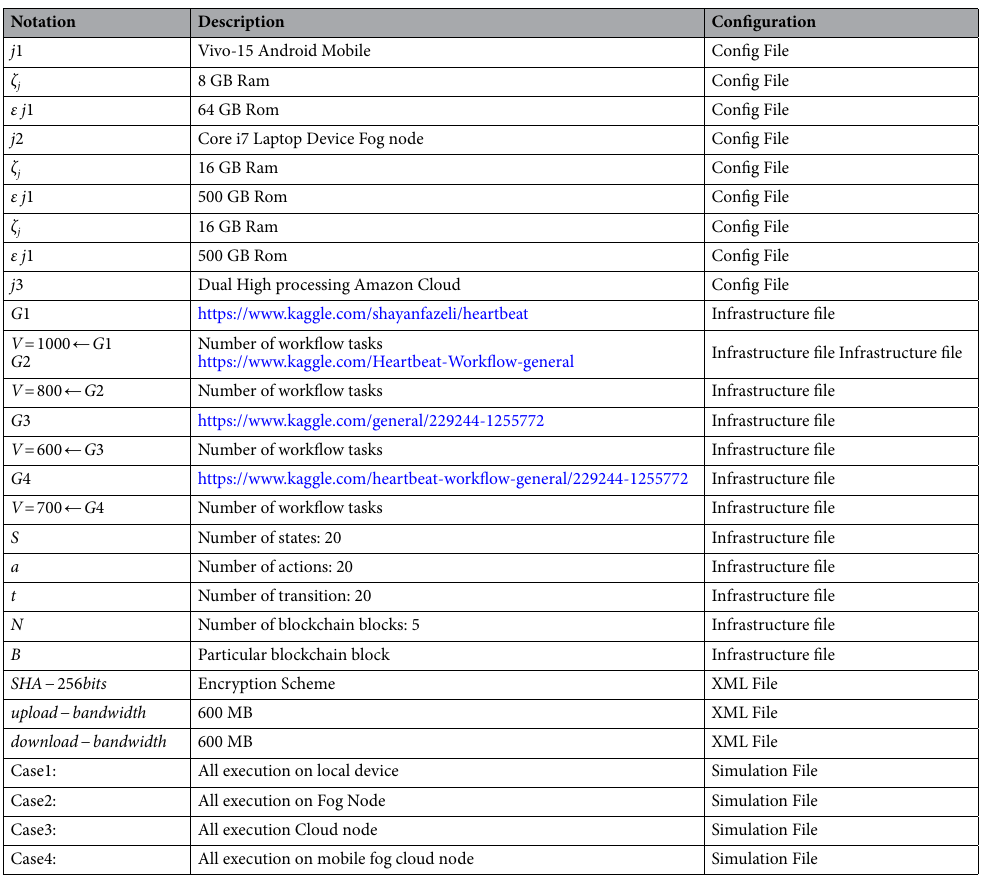
Table 1. Experimental parameter setting.